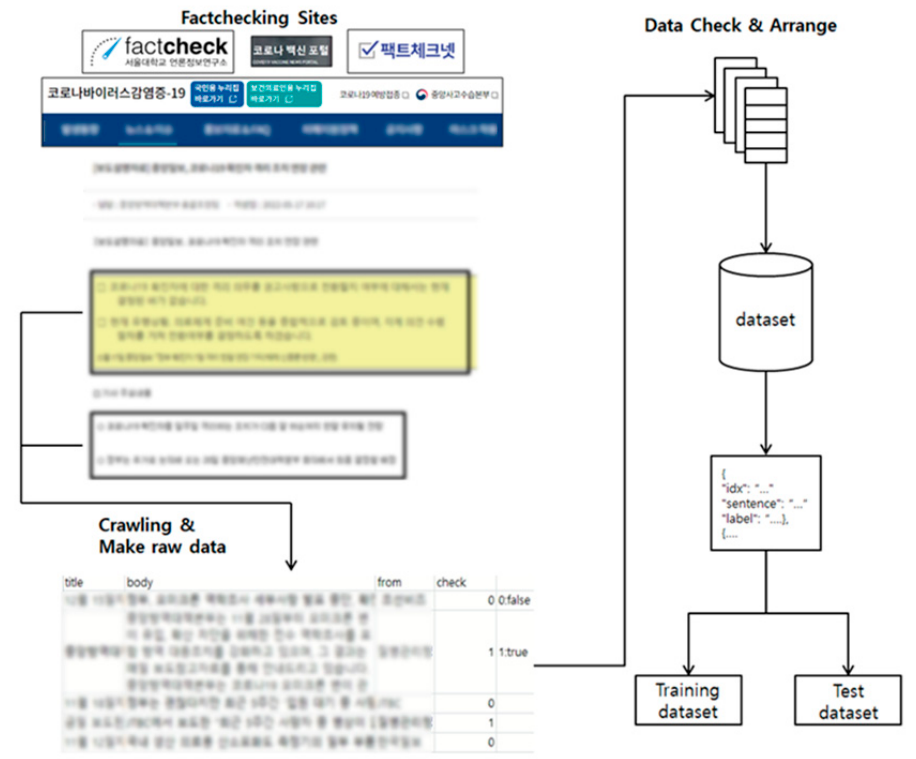
Figure 1. Dataset construction process from fact-checking websites. Table 1. An example of datasets extracted from fact-checking